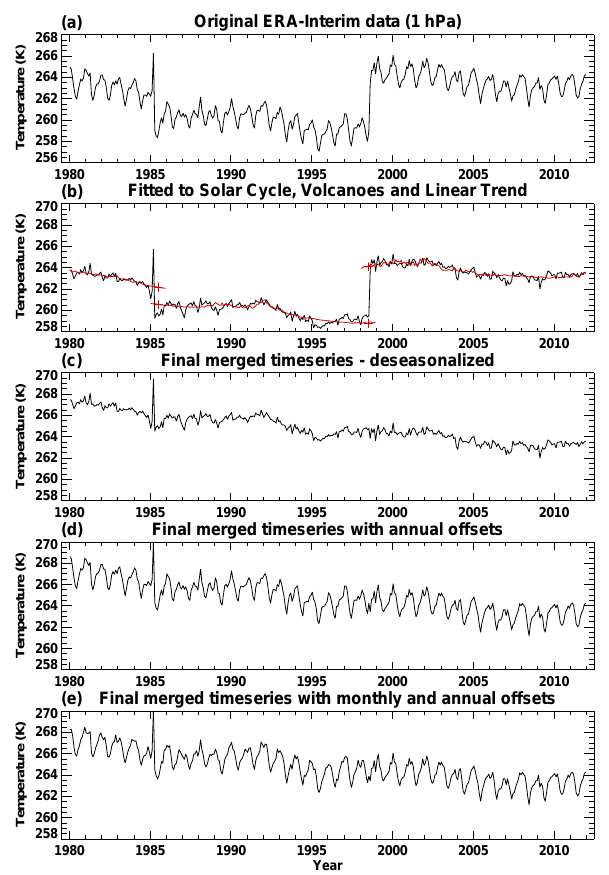
Fig. 2. Global and monthly mean ERA-Interim temperatures at 1hPa. (a) Unadjusted. (b) Deseasonalized (black) and fits to the deseasonalized time series computed over the three time periods using a linear trend and the F10.7 and volcanic aerosol time series (red). The red curves extend slightly beyond the ends of the data used for the fits to show the overlap region that is used to calculate the annual mean offsets, which are evaluated at the mid-point of the year the jump occurs denoted by the red crosses. (c) Deseasonalized time series with annual mean offsets included. (d) Same as (c) but with annual cycle included. (e) Same as (d) but with monthly mean offsets included. See text for